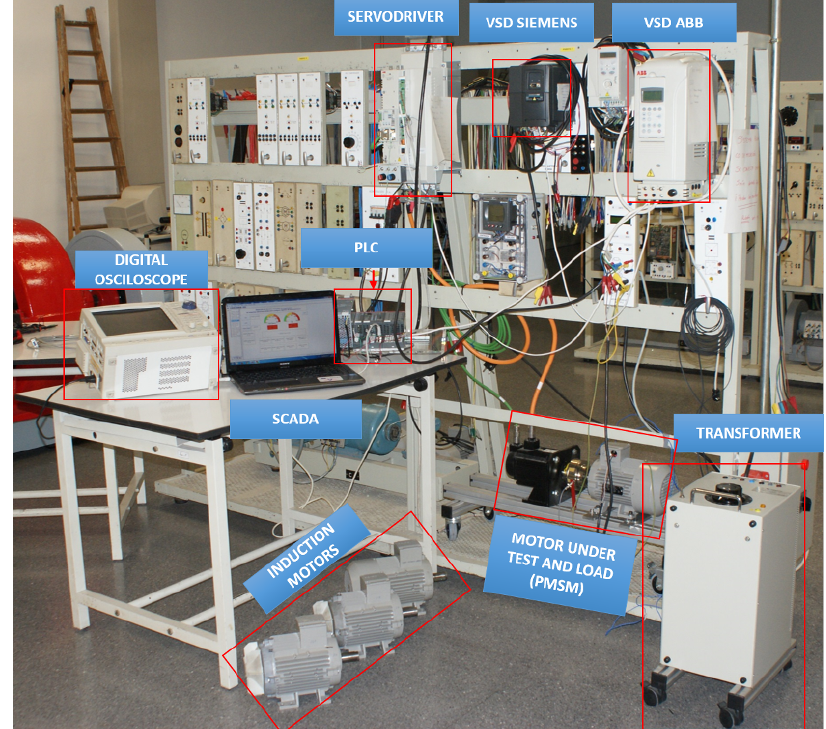
Figure 11. Test Bed used to obtain the experimental